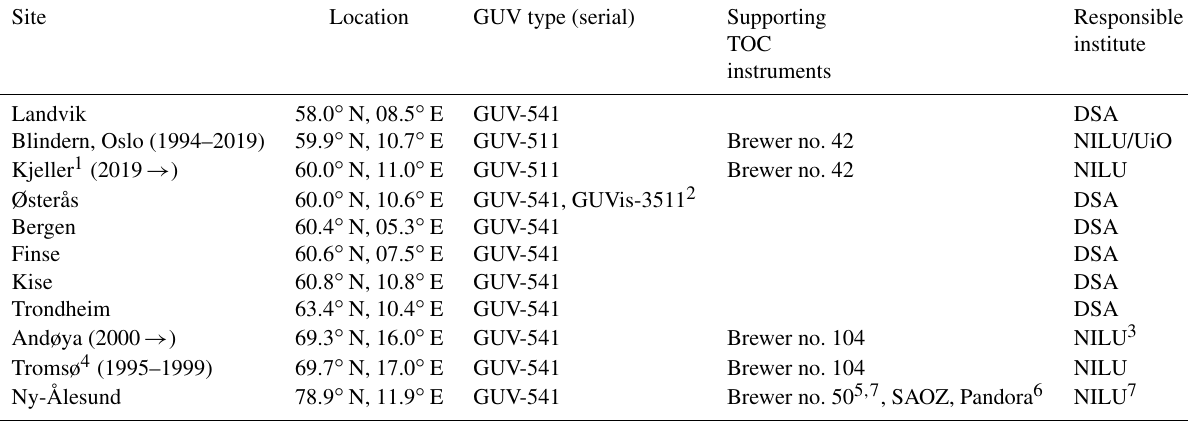
Table 1. Overview of the locations, instrument types, and institutes involved in the Norwegian UV network.